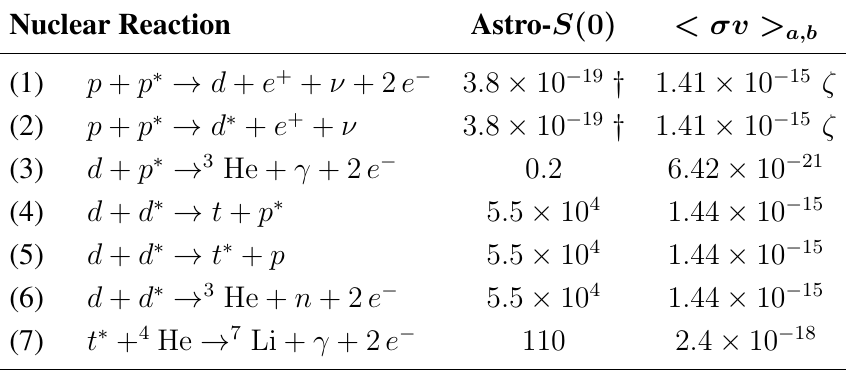
Table 1. With the Astrophysical S(0) units in eV-barns and the (reformulated) reaction rates per particle pair < σv > in cm 3 /s. ζ is a cross-section parameter; † Solar value to be a,b reformulated; see the